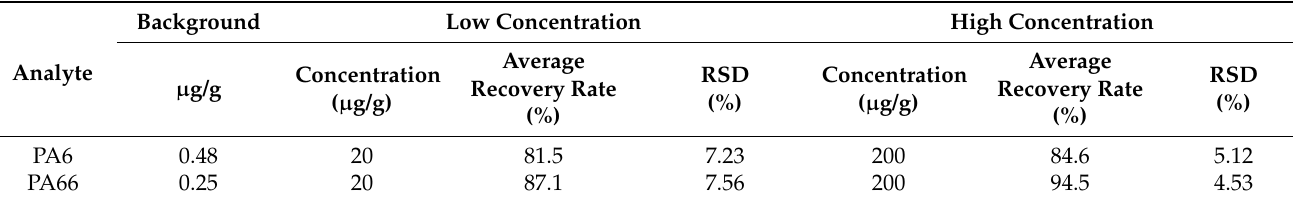
Table 4. Average recovery and RSD for mussel samples ( n =